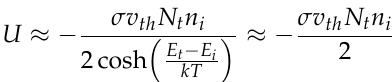
Figure 3. Various possible causes of dark current generation, illustrated in CMOS image sensor pixel cross-section. PD: photodiode; TG: transfer gate; FD: floating diffusion; RG: reset gate; RD: reset drain; GR center: generation recombination center; STI: shallow trench isolation.